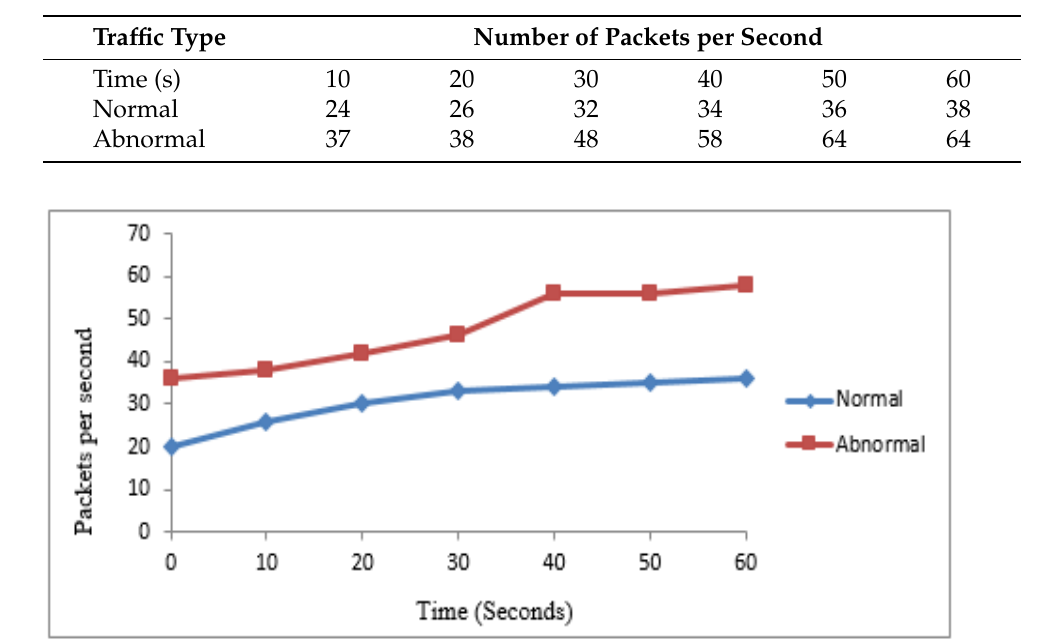
Table 3. Comparison of traffic.